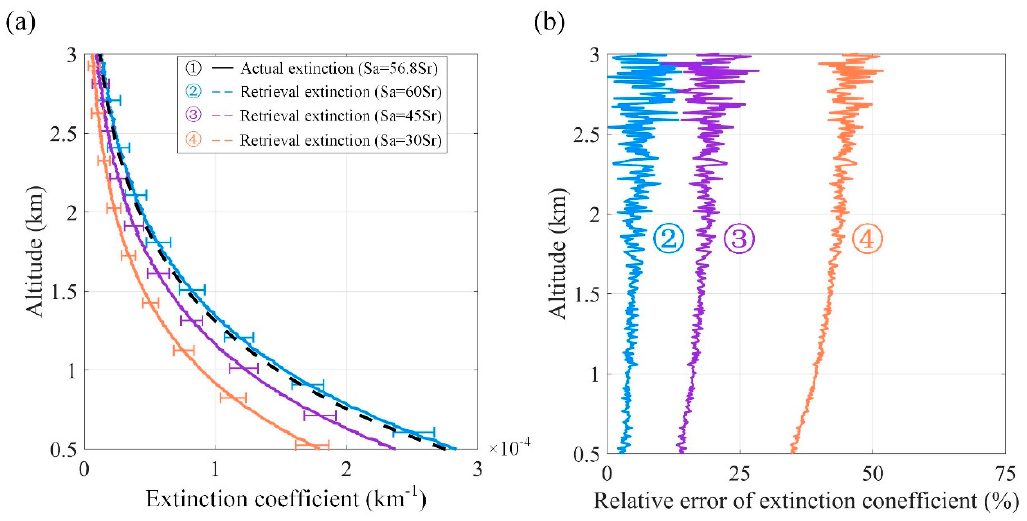
Figure 8. Take dust as an example, the Klett–Fernald method was used to retrieve the α a , as well as the relative error distribution of α a . ( a ) The results of α a retrieval using 50 simulated signal profiles in the 3 km boundary layer. The dotted black line ( ① ), the solid blue line ( ② ), the solid purple line ( ③ ), and the solid orange line ( ④ ) represent the simulated actual α a (the lidar ratio was 56.8 Sr) and the average of α a retrieval after substituting three reference lidar ratios (lidar ratios of 60, 45, and 30 Sr). The three error bars represent the standard deviation of α a retrieval using the three reference lidar ratios ( b ) Relative error profile of α a retrieval using three reference lidar ratios.